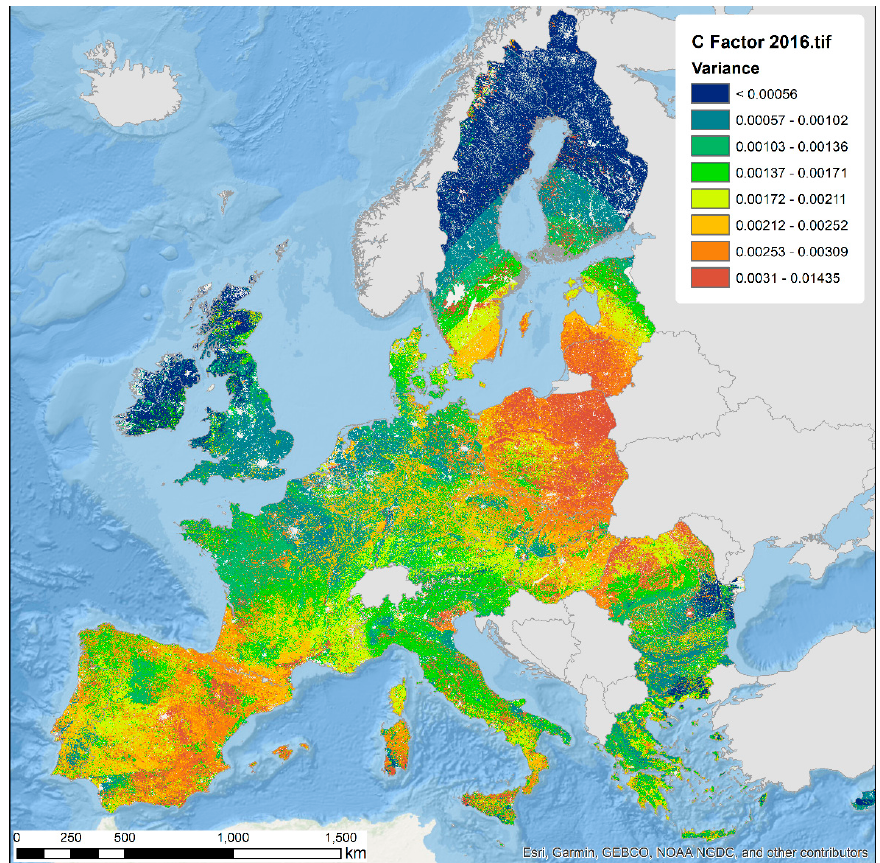
Figure A2. The variance of the C-factor used for estimating the uncertainty.